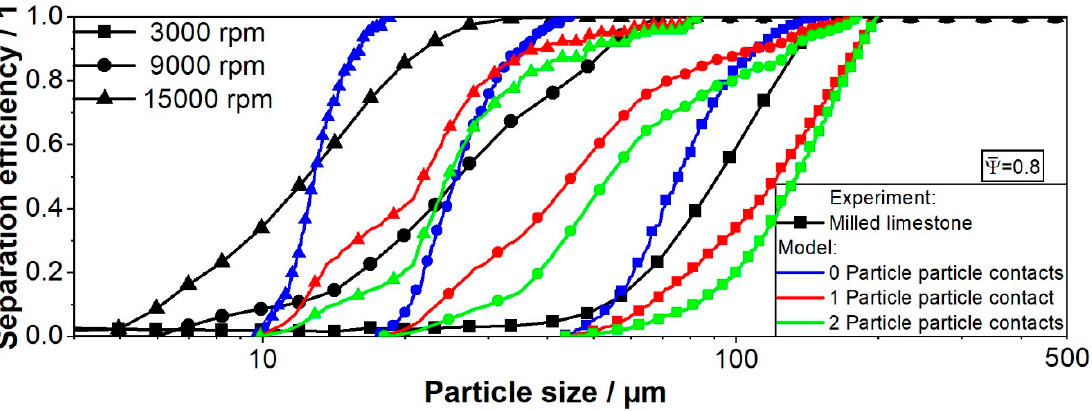
Figure A4. Experimental separation curves compared to the model predictions of 0, 1, and 2 particle–particle contacts during the separation process for limestone. This was calculated by weighting Cases A, B, and C according to Figure 12, right (neglecting the weighting from Figure 11, left) to show the range of the results if no DEM simulations were